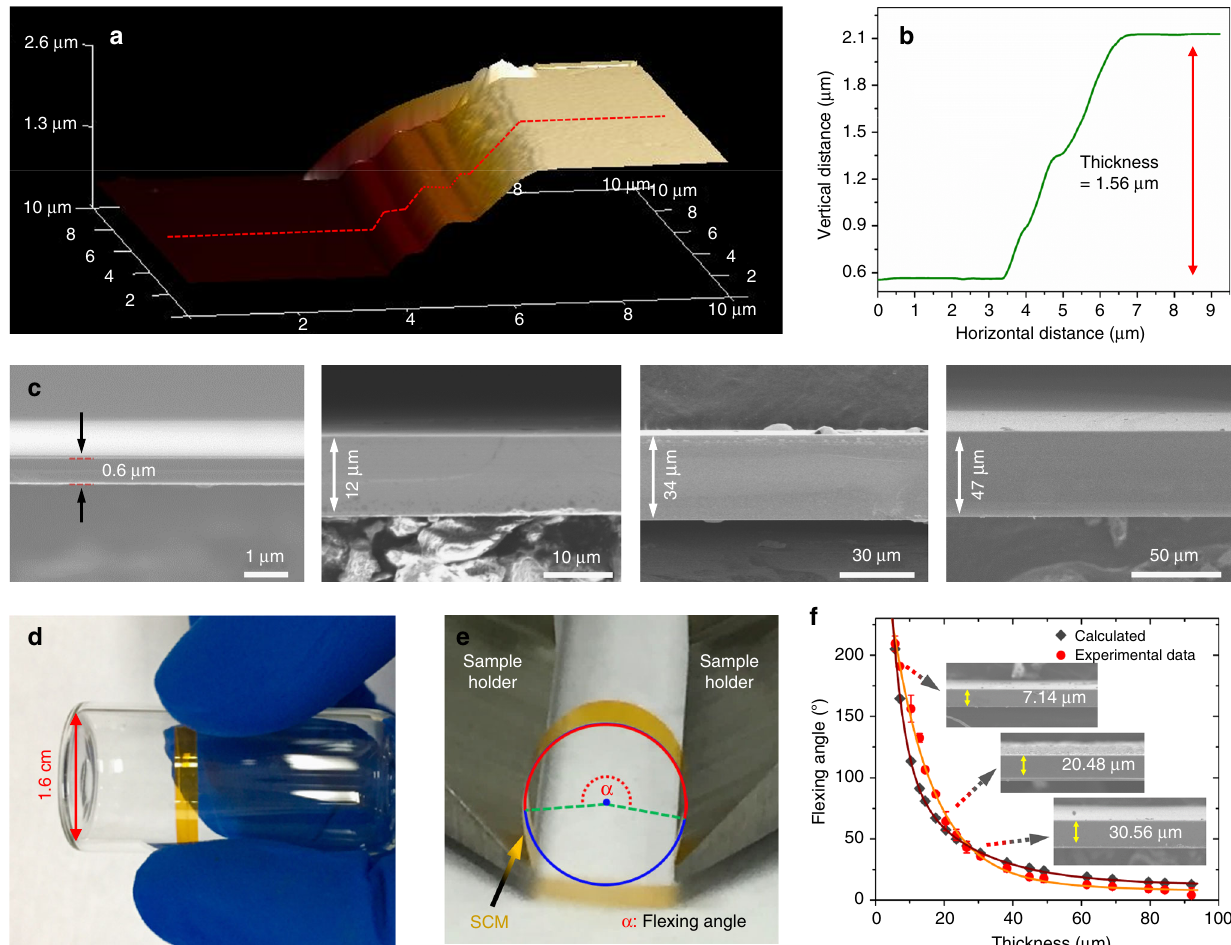
Fig. 3 Thickness control and fl exibility of (PEA) 2 PbI 4 SCMs. a 3D AFM image of a (PEA) 2 PbI 4 SCM and b height pro fi le of the line scan. c Cross-sectional SEM images of the (PEA) 2 PbI 4 SCMs with different thicknesses (0.6, 12, 34, 47 μ m). d Photo of a piece of (PEA) 2 PbI 4 SCM, 3.5 μ m in thickness, wrapped around a small tube (1.6 cm in diameter) to show its fl exibility. e A photo showing the fl exing angle measurement for the (PEA) 2 PbI 4 SCM. f Correlation of the (PEA) 2 PbI 4 SCM thickness and corresponding fl exing angle, with the insets showing cross-sectional SEM images of the (PEA) 2 PbI 4 SCMs with three thicknesses (7.14, 20.48, 30.56 μ